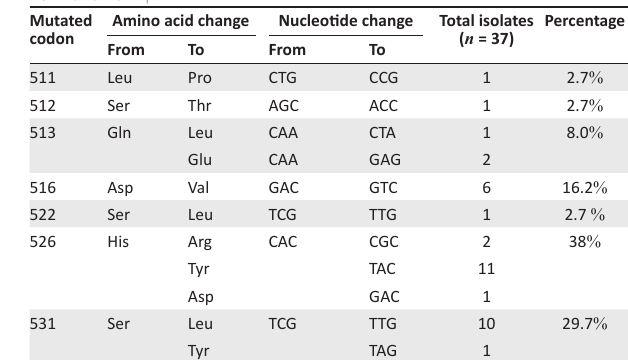
TABLE 2: Distribution of mutations in codons 491–574 of the rpo B gene and amino acid changes in the rifampicin resistance determining region,